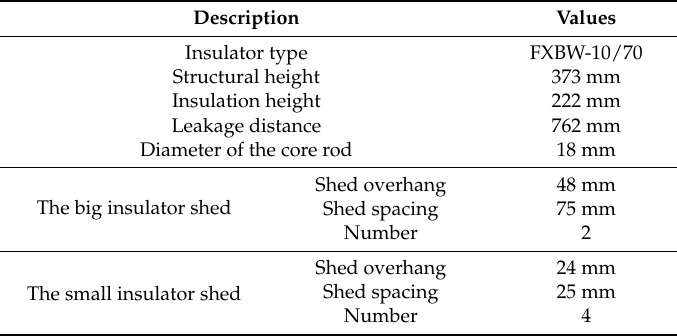
Table 2. Parameters of composite insulator